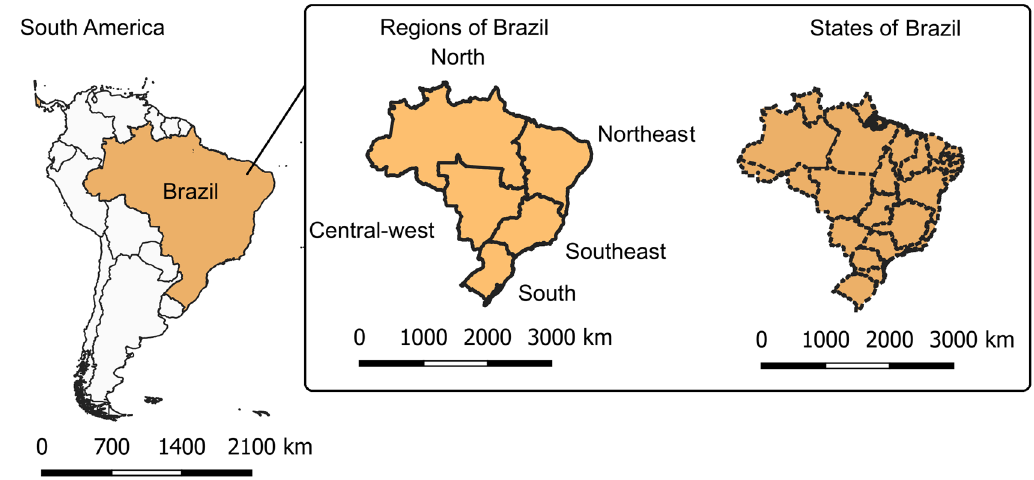
Figure 1. Study area: Brazil and its regions.